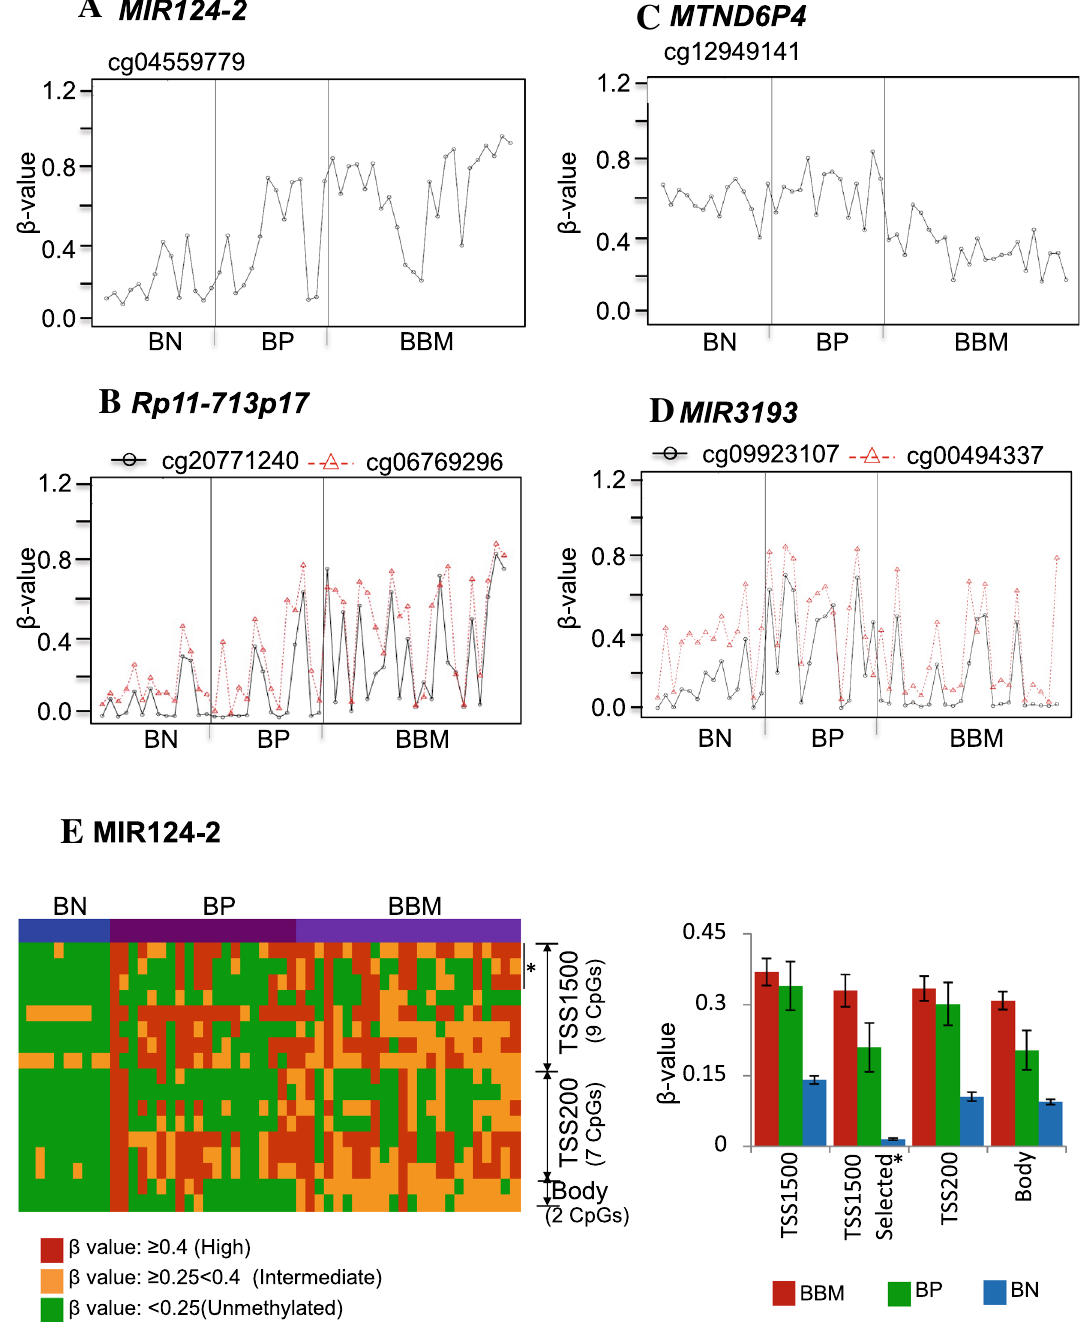
Figure 1. Genome-wide DNA methylation analyses by 450 K array for BBM, primary breast tumours (BP) and normal breast tissues (BN) identified CpG loci which have either gained methylation (hypermethylated) or have lost methylatioin (hypomethylated) in BBM compared to BP and BN tumours. Representative examples of gene- associated CpG loci that have gained methylation (hypermethylated) in BBM ( A,B ) or have lost methylation (hypomethylated) in BBM ( C,D ) compared to BP and BN (as measured by β-value). ( E ) Regional methylation pattern of MIR124-2 showing the the location of all CpG loci present on the 450 K array relative to the transcription start of the gene and the differing methylation levels for each loci in BBM, BP and BN. * denotes the location of the differentially methylated CpG that was identified by the bioinformatic analysis of 450 K-array data from BN, BP and